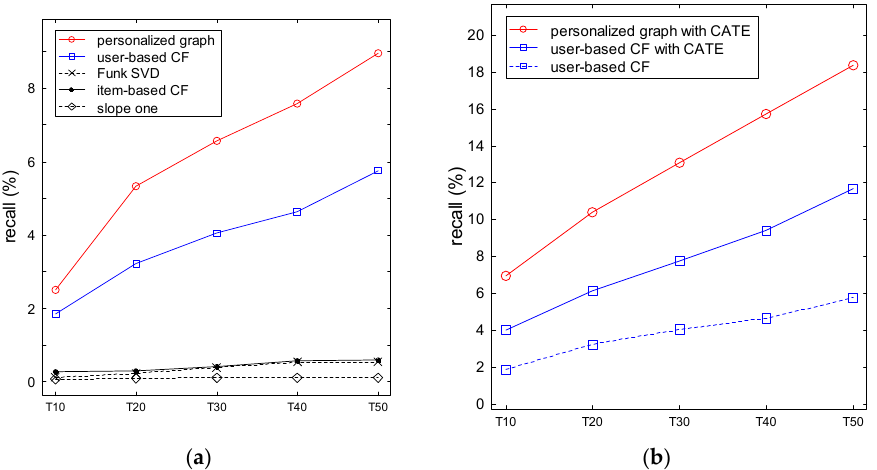
Figure 9. Comparison with existing collaborative filtering (CF) methods. ( a ) Without category purchase probabilities. ( b ) With category purchase probabilities.